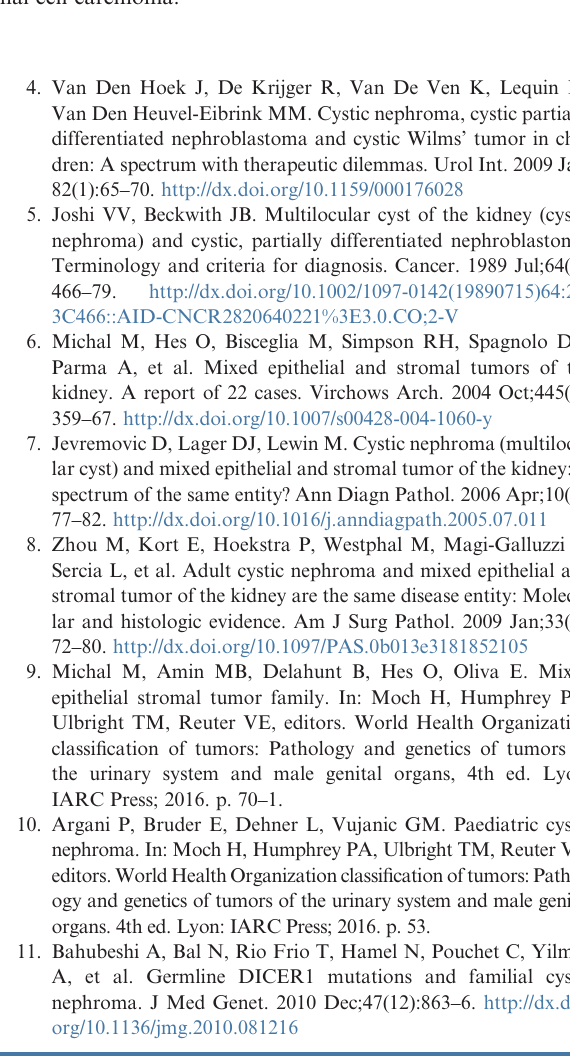
Figure 4. CT axial scan during arterial phase of a 44-year-old male (same patient of Figure 3) shows a minute hypervascular solid component located in the cranial portion of the clear cell renal cell